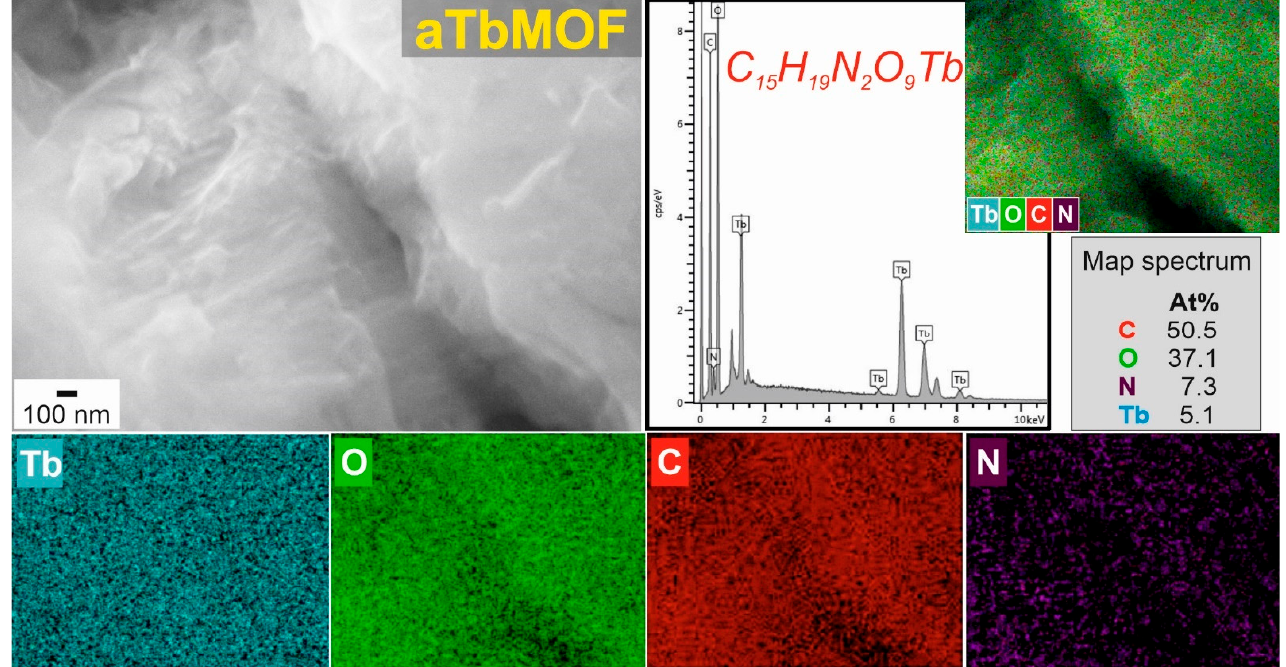
Figure 5. SEM surface morphology images of amorphous (aTbMOF) powder and EDS elemental mapping.